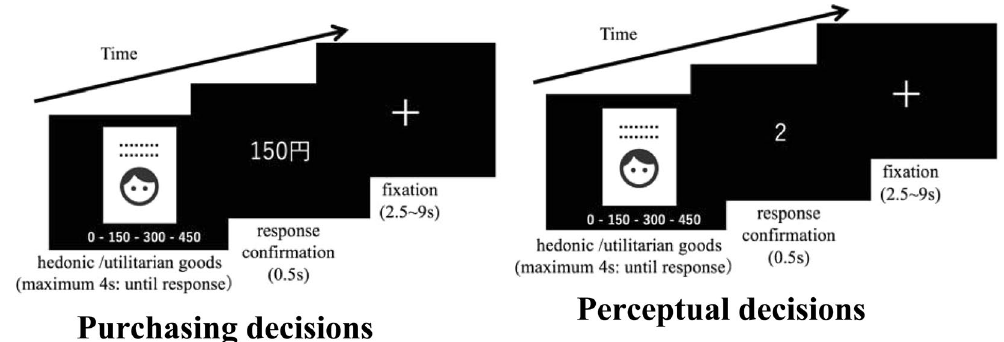
Figure 1. Participants performed two types of task in relation to identical stimuli (book cover: hedonic/ utilitarian). ( A ) For purchasing decisions, participants indicated their willingness to pay a specific price for that book. ( B ) For perceptual choices, participants indicated the total number of people and lines on the book